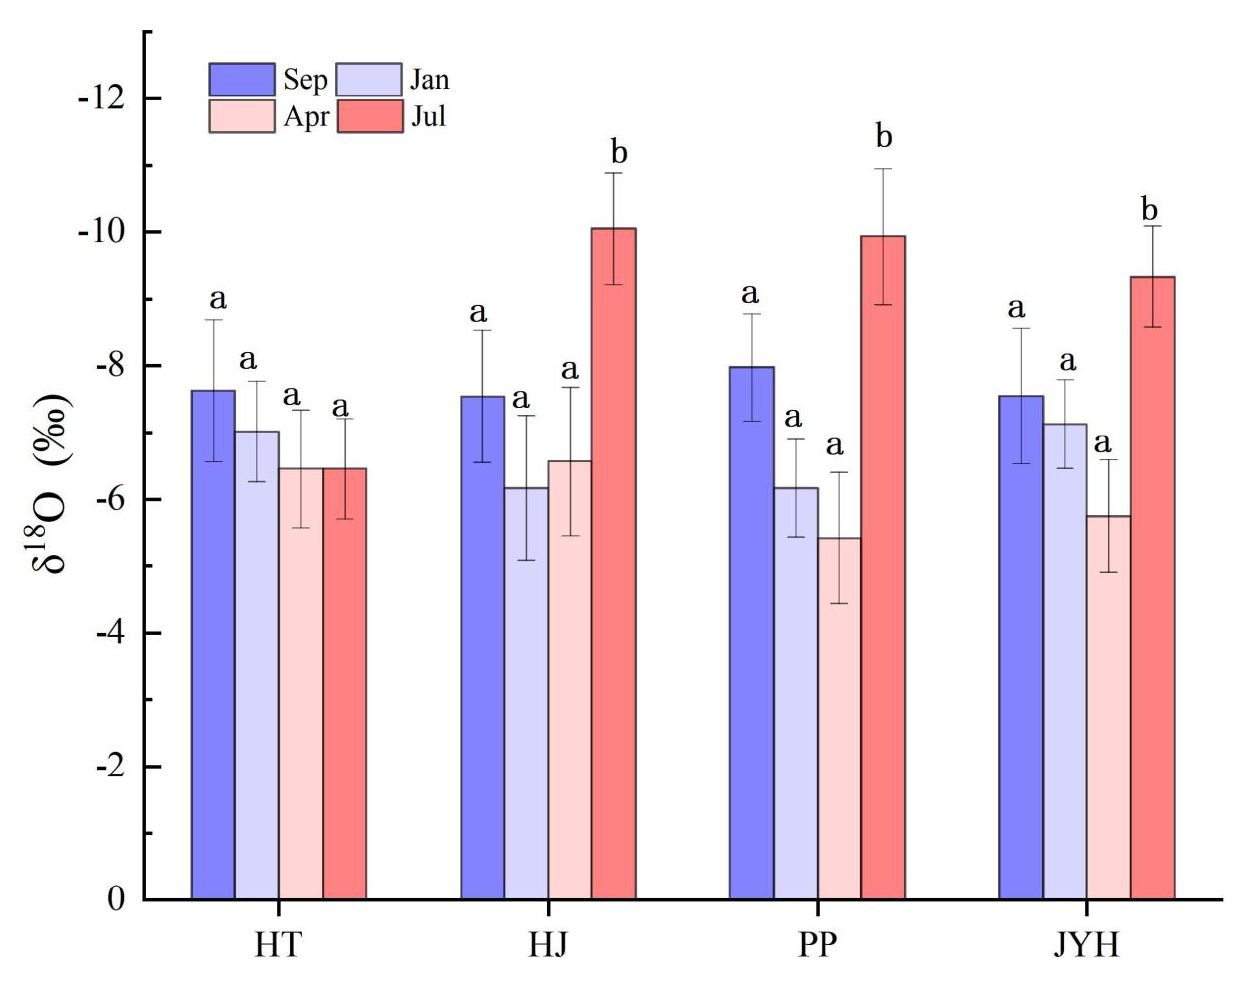
Figure 6. Significant differences in soil water isotope composition of four plants in the same month. a and b represent different significant differences. Error bars represent standard deviations, p < 0.05.